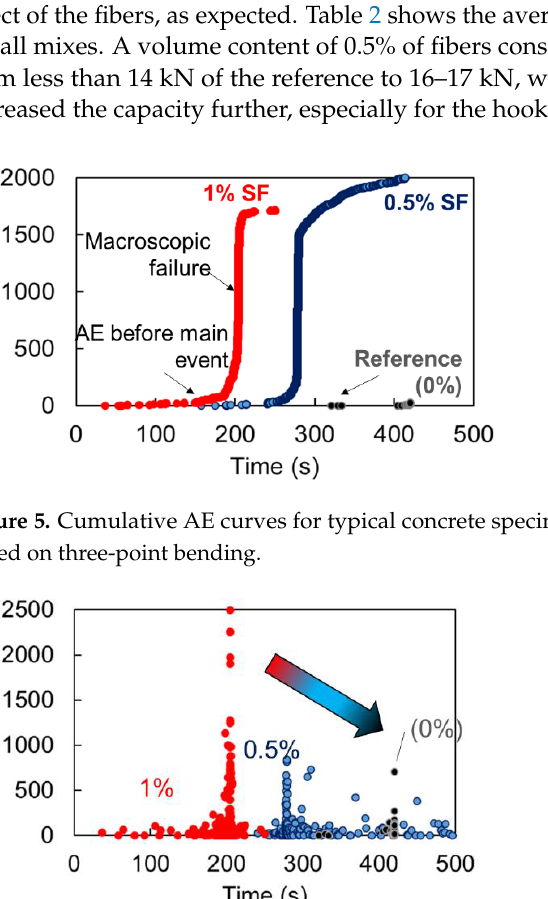
Figure 6. Rise time for concrete specimens with different vol.% of steel fibers tested on 3p-bend-